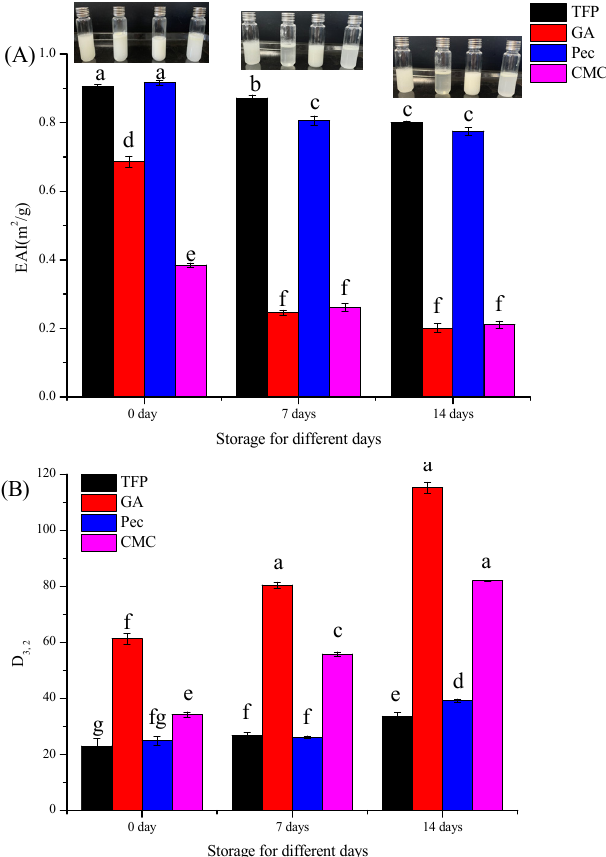
Figure 4. The EAI ( A ) and D 3,2 ( B ) of different emulsions after storage for 0, 7, and 14 days at room temperature. (Different lowercase letters in indicate a significant difference of EAI ( A ) and D 3, 2 ( B ) at p < 0.05).